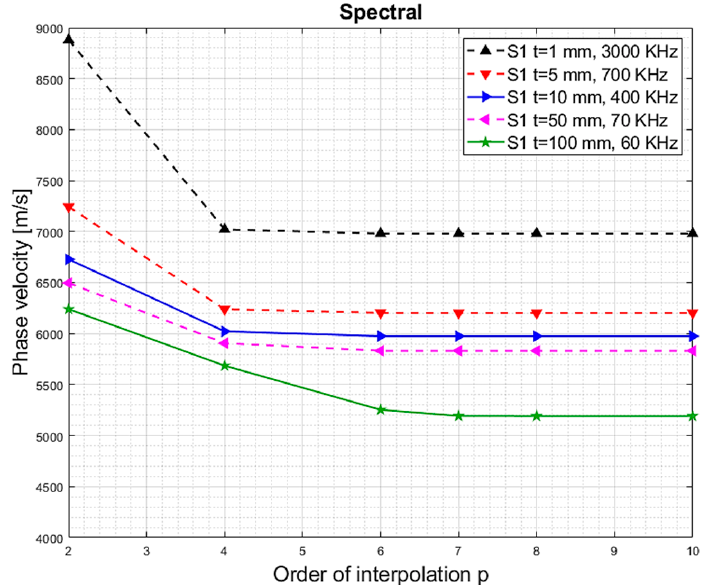
Figure 9. Comparison of the convergence curves for spectral elements of different orders of interpolation p and thicknesses between 1 mm and 100 mm.